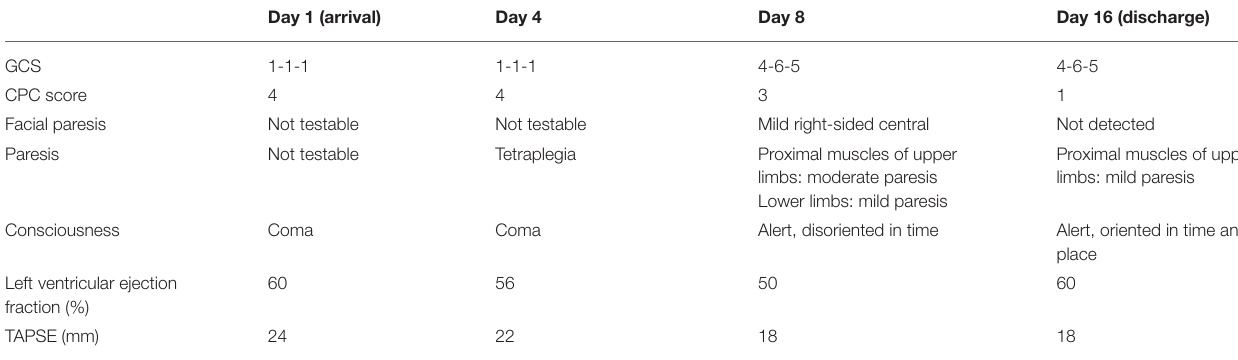
TABLE 1 | Timeline of the case, condition of our